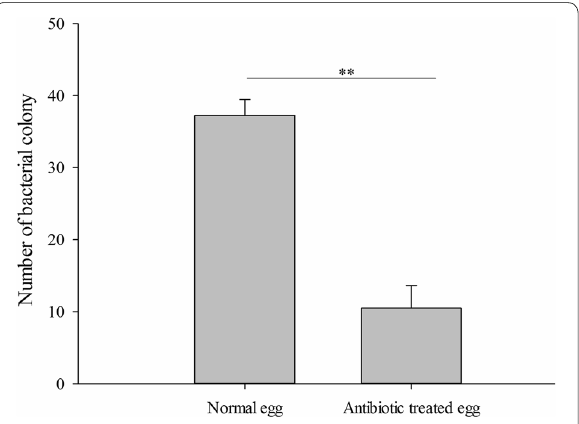
Fig. 4 Number of cultivated Gluconobacter cerinus strain CDF1 colo- nies separated from the eggs treated with antibiotic. **p <